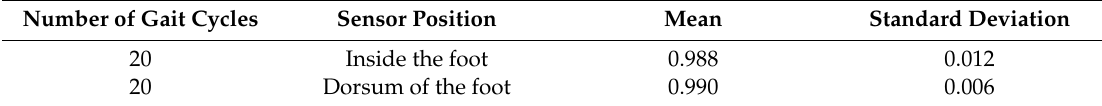
Table 2. Results: angular velocity data in the y-direction (cross-correlation).